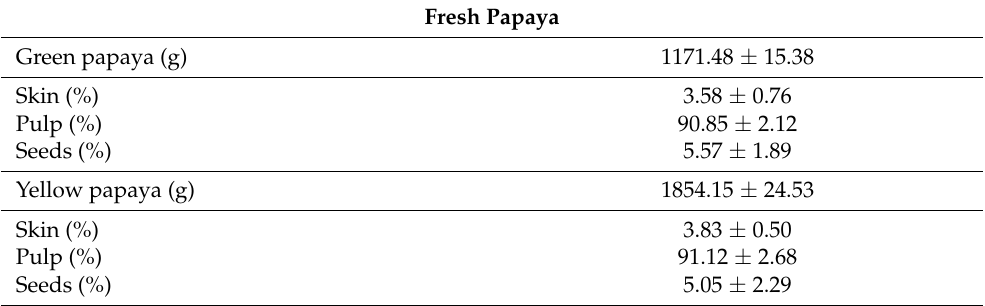
Table 1. Fraction of skin, pulp, and seeds in fresh